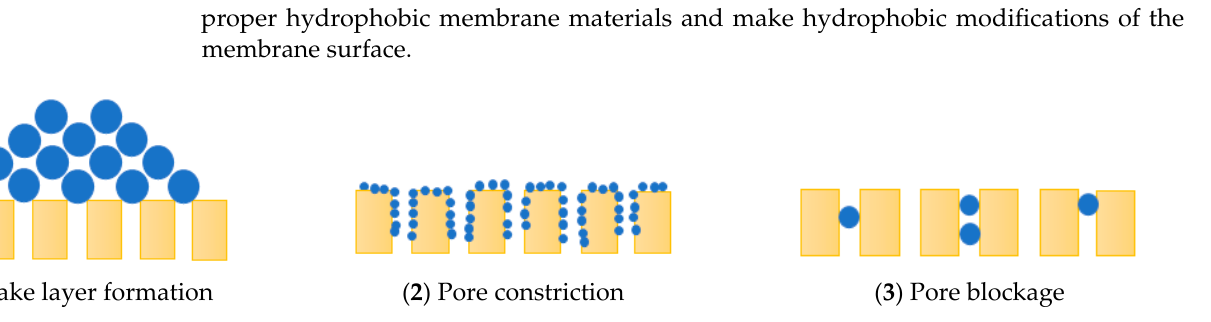
4 of 53 Figure 2. Fouling on membrane surface of MD: ( 1 ) inorganic fouling, ( 2 ) organic fouling, ( 3 ) biolog- ical fouling [17–19]. Figure 2 shows different foulants on the membrane surface. Fouling can also be classified into reversible and irreversible fouling according to the degree of its cleaning recovery [20]. Figure 3 shows three different mechanisms of fouling: cake layer fouling, pore constriction and pore blockage. The first two types are reversible fouling since the cake layer and the adsorption of foulants on the pore surface can be cleaned by suitable cleaning methods such as backwashing, etc. Conversely, when pore blockage occurs, it cannot be cleaned completely. Therefore, pore blockage can be regarded as irreversible fouling [21]. The existence of membrane fouling can increase trans-membrane resistance and decrease membrane flux. The formation of the cake layer or the biofilm on the mem-